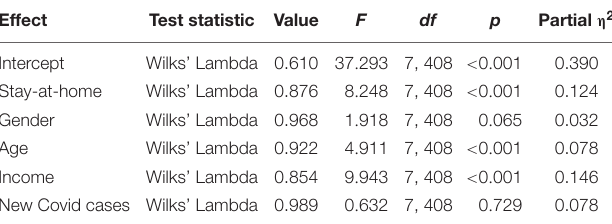
TABLE 6 | Results multivariate tests of effects stay-at-home order, gender, age, income and #new covid infections per 100k inhabitants on resilience and components of well-being.